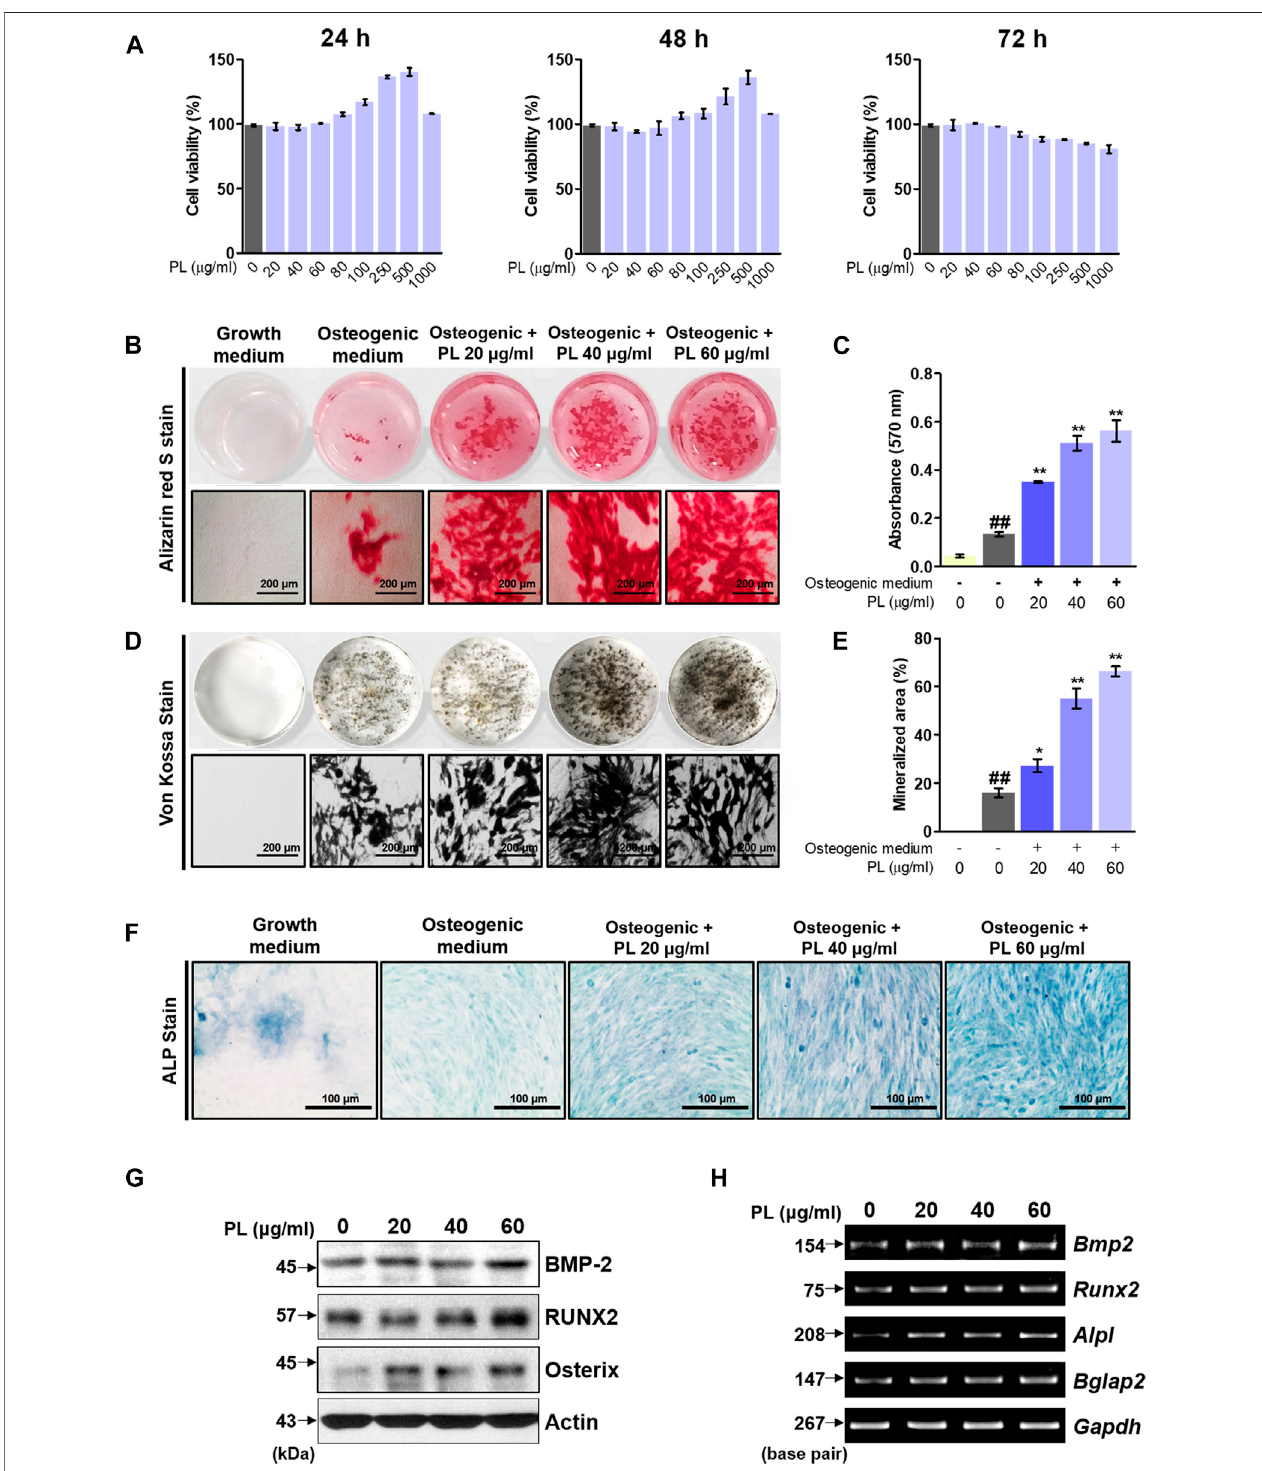
FIGURE 2 | Effect of PL on osteoblast differentiation and bone mineralization. (A) The toxicity of PL in MC3T3-E1 cells was determined using a CCK-8 assay. (B) The effect of PL on mineralized nodule formation was analyzed by alizarin red S ( × 100 magni fi cation, 200 μ m). (C) The stained dye was extracted and measured at an absorbanceof570 nmbyELISA. (D) AplateviewofvonKossastainingwascapturedusingacameraandmicroscope( × 100magni fi cation,200 μ m). (E) Themineralized areawasmeasuredusingImageJsoftware. (F) ALPexpressioninMC3T3-E1cellswasdeterminedusinganALPStainingKit( × 200magni fi cation,100 μ m) (G) The protein levels of BMP-2, RUNX2 and Osterix were measured by western blot. (H) RNA expression of BMP-2 ( Bmp2 ), RUNX2 ( Runx2 ), ALP ( Alpl ) and OCN ( Bglap ) was detected by RT-PCR. These are presented as the mean ± SEM ( n (cid:2) 3 for each experimental). ## p < 0.01 vs. the growth medium cells; ** p < 0.01 and * p < 0.05 vs. osteogenic medium